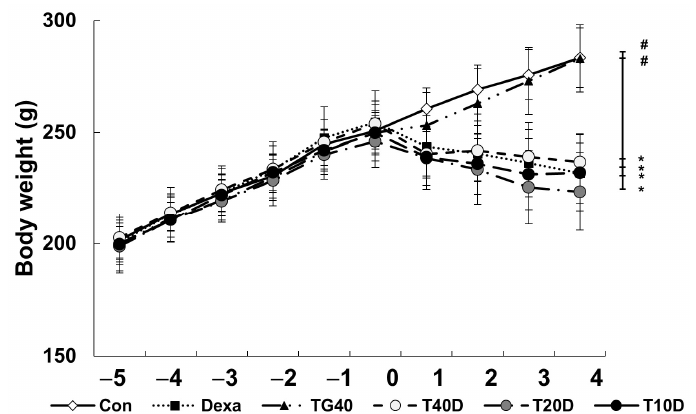
Figure 1. Body weight of rats before and after Dexa administration. The rats were supplemented with teaghrelin at 40 mg/kg (TG40) or with saline (Con) for 10 days, and Dexa was injected into the rats in the last five days, with the supplementation of teaghrelin (0, 10, 20 or 40 mg/kg, Dexa, T10D, T20D, or T40D) for 10 days. During the experimental period, the body weight of the rats was measured daily. The results were analyzed using one-way ANOVA. Values are presented as the mean ± SD (n = 5 or 6). * p < 0.05 versus Con; # p < 0.05 versus Dexa.